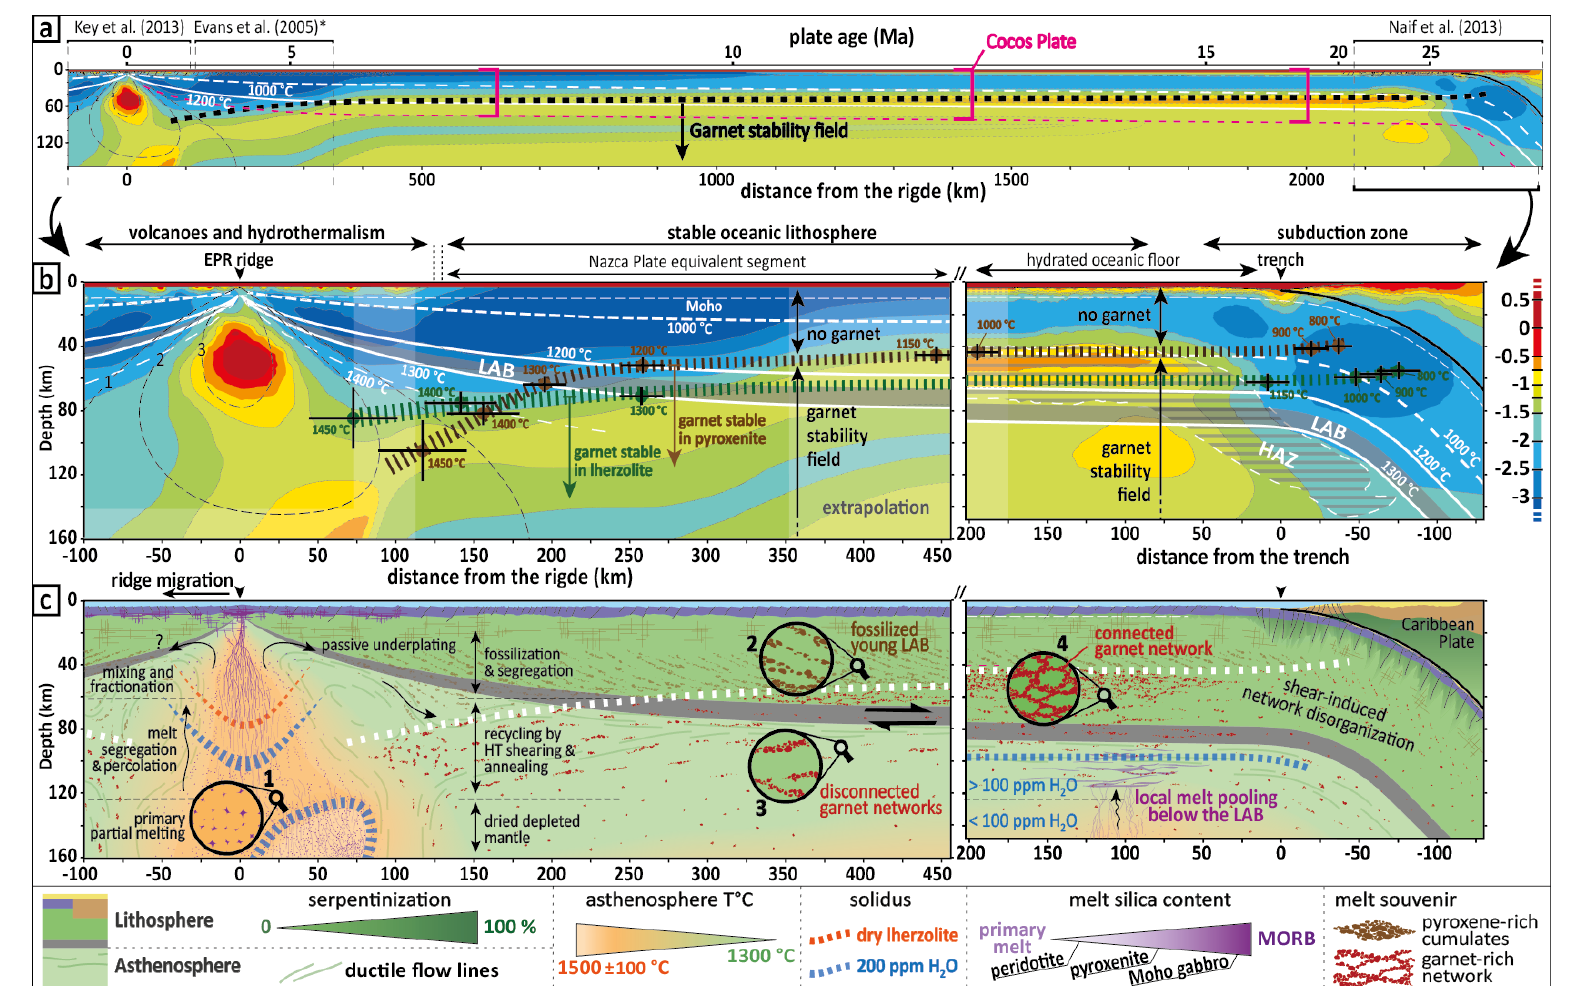
Figure 8. Synthetic cross-section of the Cocos Plate showing the electrical conductivity in the spreading direction, including an equivalent segment from the Nazca Plate. ( a ) Overview of the electrical structure of the Cocos plate from the EPR to the subduction o ff shore Nicaragua. ( b ) Focus on the youngest portion (EPR) [21]